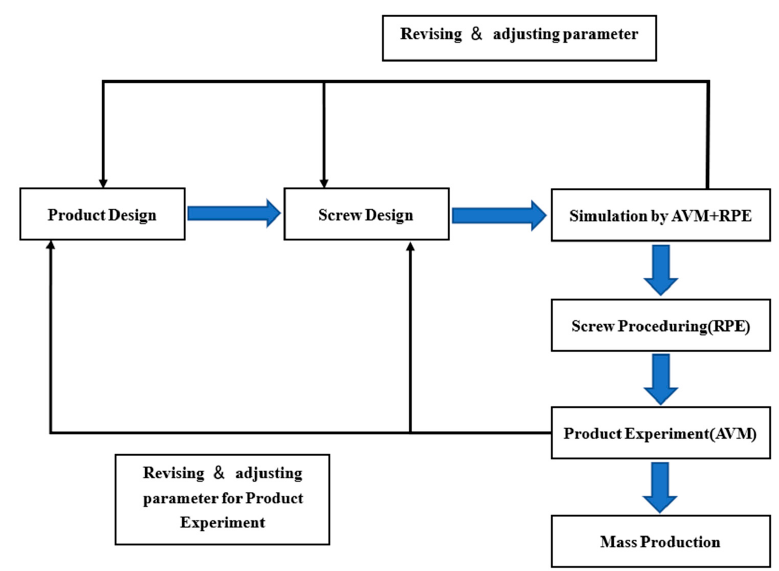
Figure 2. Flowchart of AVM+RPE method.